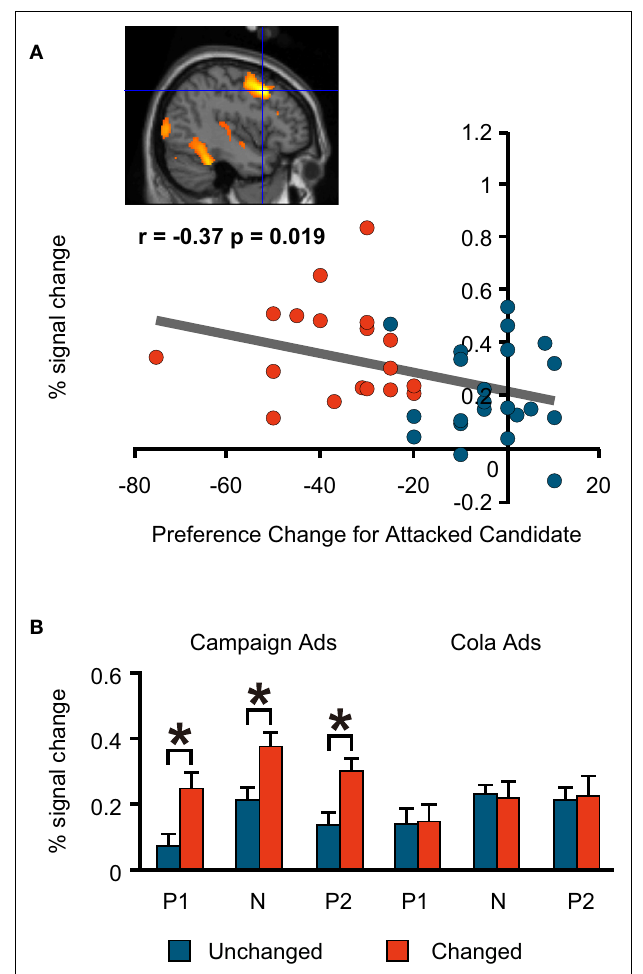
FIGURE 5 | fMRI signal change at the left dorsolateral prefrontal cortex ( − 42, 16, 40; BA9/6). (A) The correlation between the signal change during the negative advertisements and the preference change towards a favoured candidate during the negative advertisements (=post-negative-advertisement preference for the attacked candidate − pre-negative-advertisement preference for the attacked candidate). (B) Mean comparison between the Unchanged and Changed Groups for each advertisement